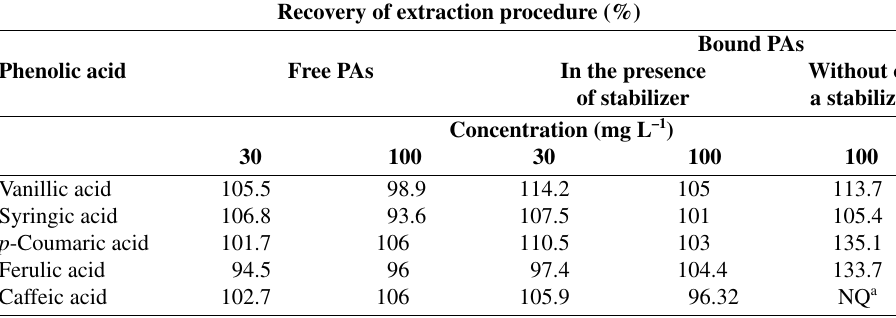
Table 5. Determination of the method accuracy expressed as recovery (%).